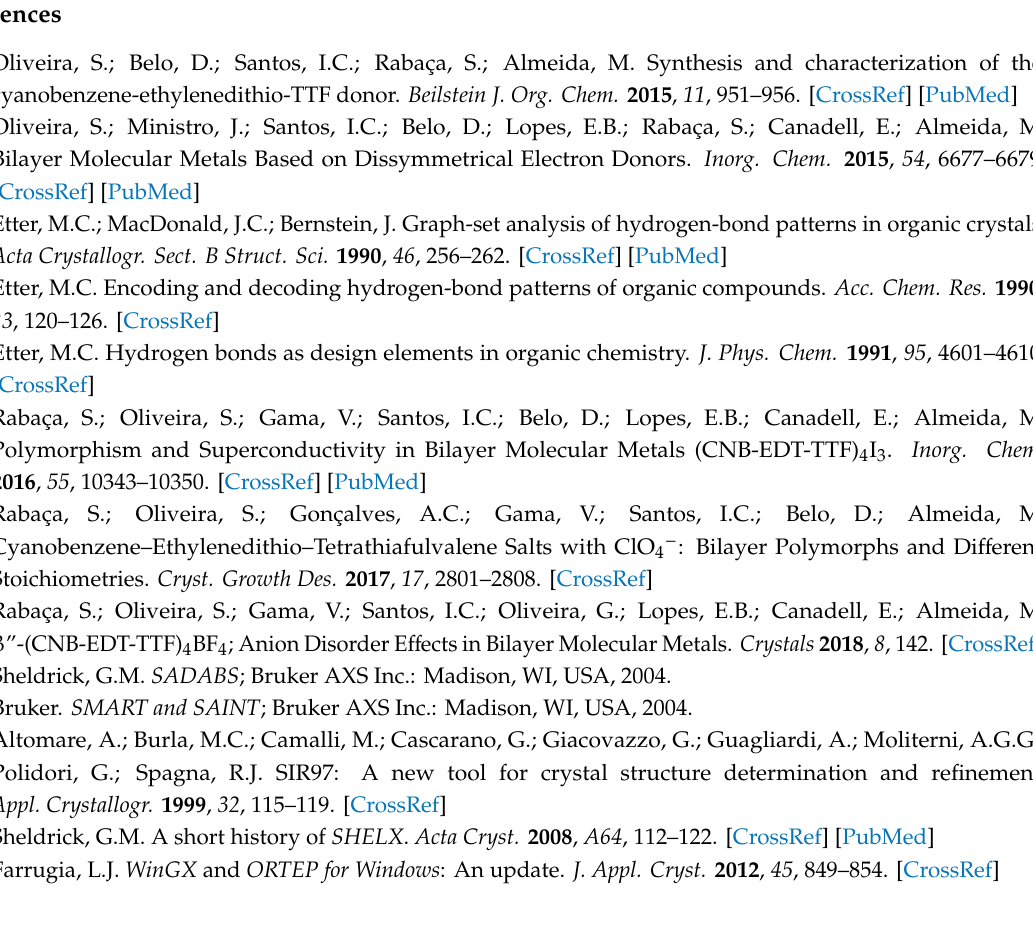
Supplementary Materials: The following are available online at http: // www.mdpi.com / 2073-4352 / 9 / 12 / 608 / s1, Table S1: Strongest computed molecular vibrational modes of the charged CNB-EDT-TTF cation in the range from 700 to 3000 cm − 1 ; Figure S1: Temperature evolution of the ν 4 and ν 5 modes in the tetrahedral ClO 4 − , ReO 4 − and octahedral SbF 6 − anion salts; Figure S2: The C ≡ N stretching motion for di ff erent temperatures for (CNB-EDT-TTF) 4 ClO 4 , (CNB-EDT-TTF) 4 ReO 4 and (CNB-EDT-TTF) 4 SbF 6 ; Figure S3: Temperature dependence of the vibrational features related to the anion vibrations of ClO 4 − and ReO 4 − observed in the optical